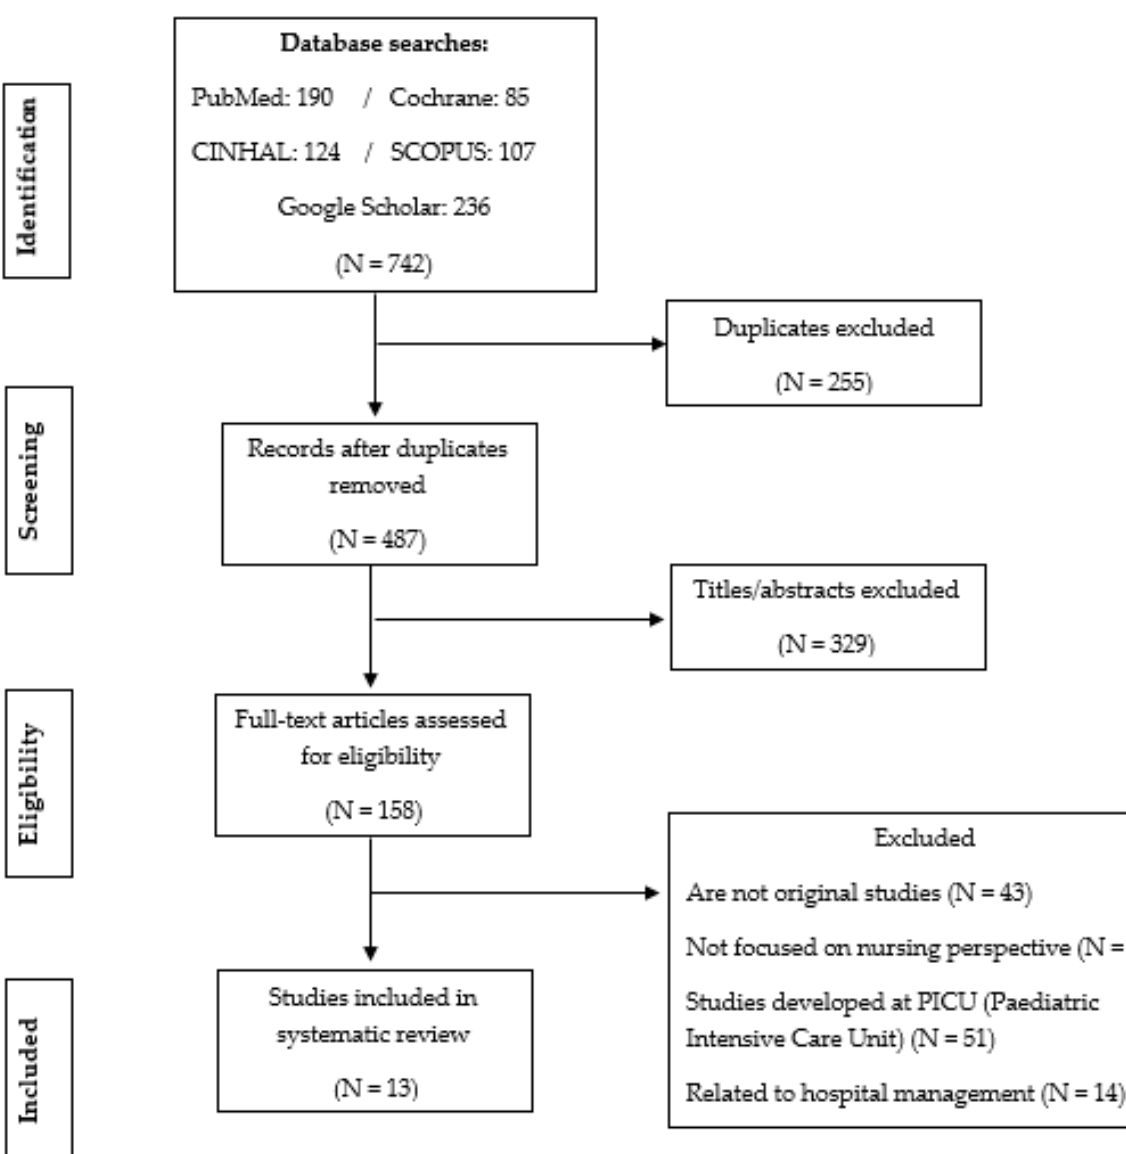
Figure 1. The flow of articles through the search process.